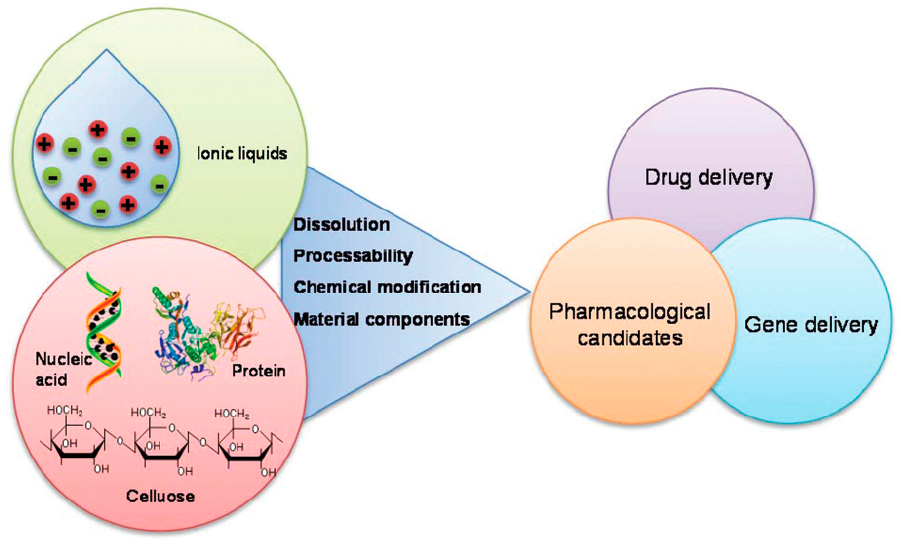
Figure 4. Strategies and application of IL/biopolymer materials. Reprinted with permission from [68].